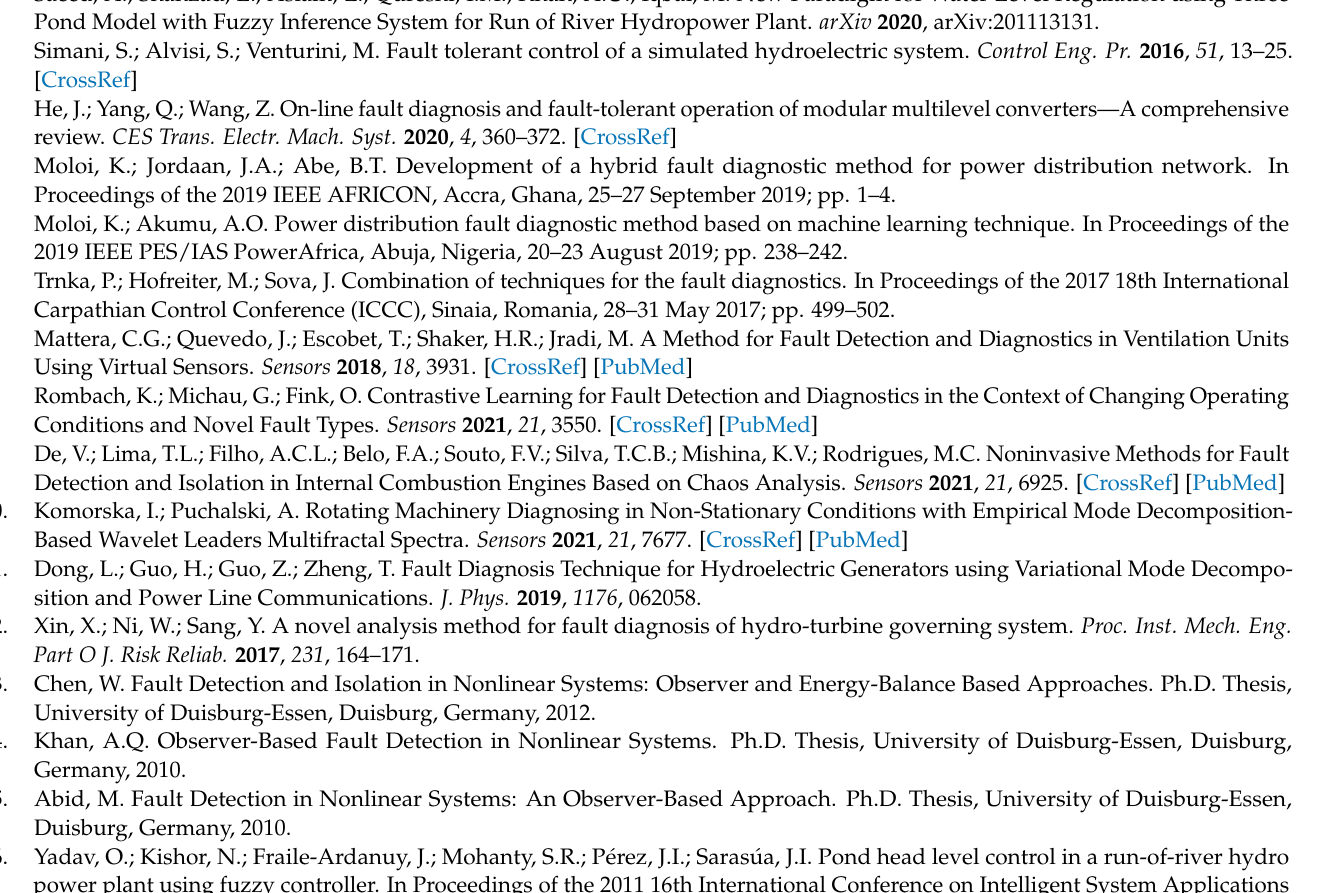
Figure 1. Three-pond hydraulic